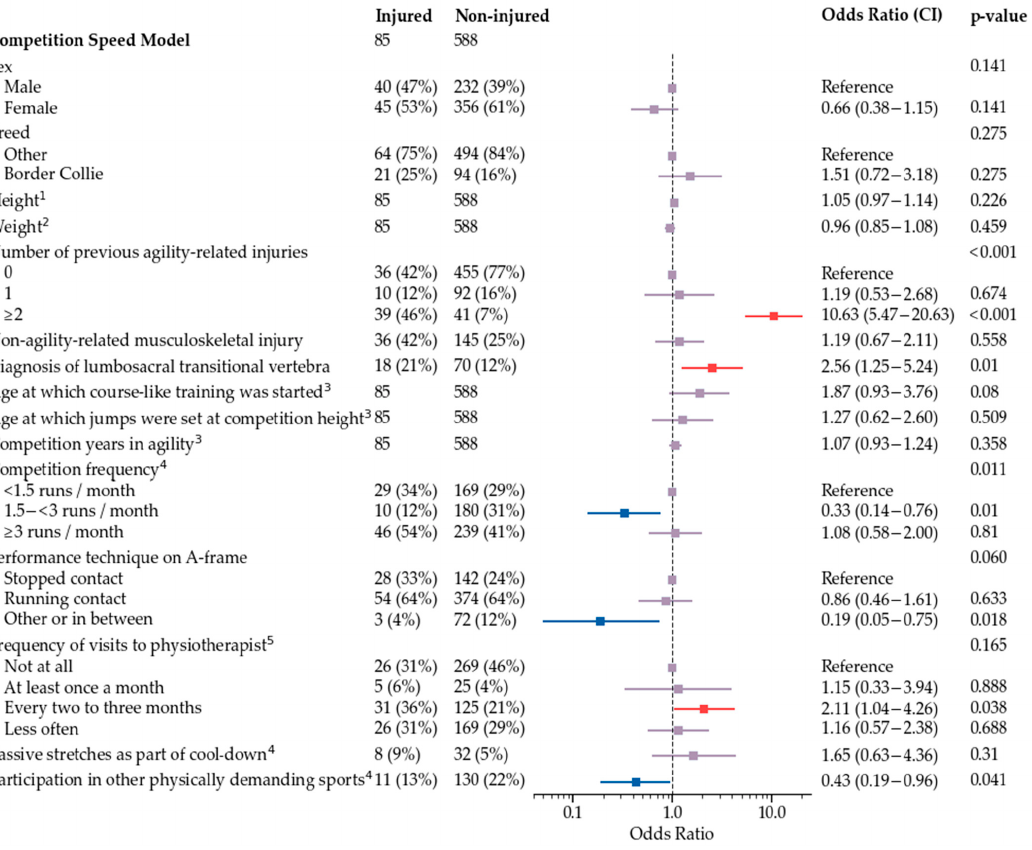
Figure 5. Competition speed model for odds of agility-related injury during 2019. 1 For a one centimeter increase, the odds increase by OR. 2 For a one kilogram increase, the odds increase by OR. 3 For a one year increase, the odds increase by OR. 4 Routines during the three-month period preceding injury in injured dogs and during 2019 in non-injured dogs. 5 Routines during the one-year period preceding injury in injured dogs and during 2019 in non-injured dogs.